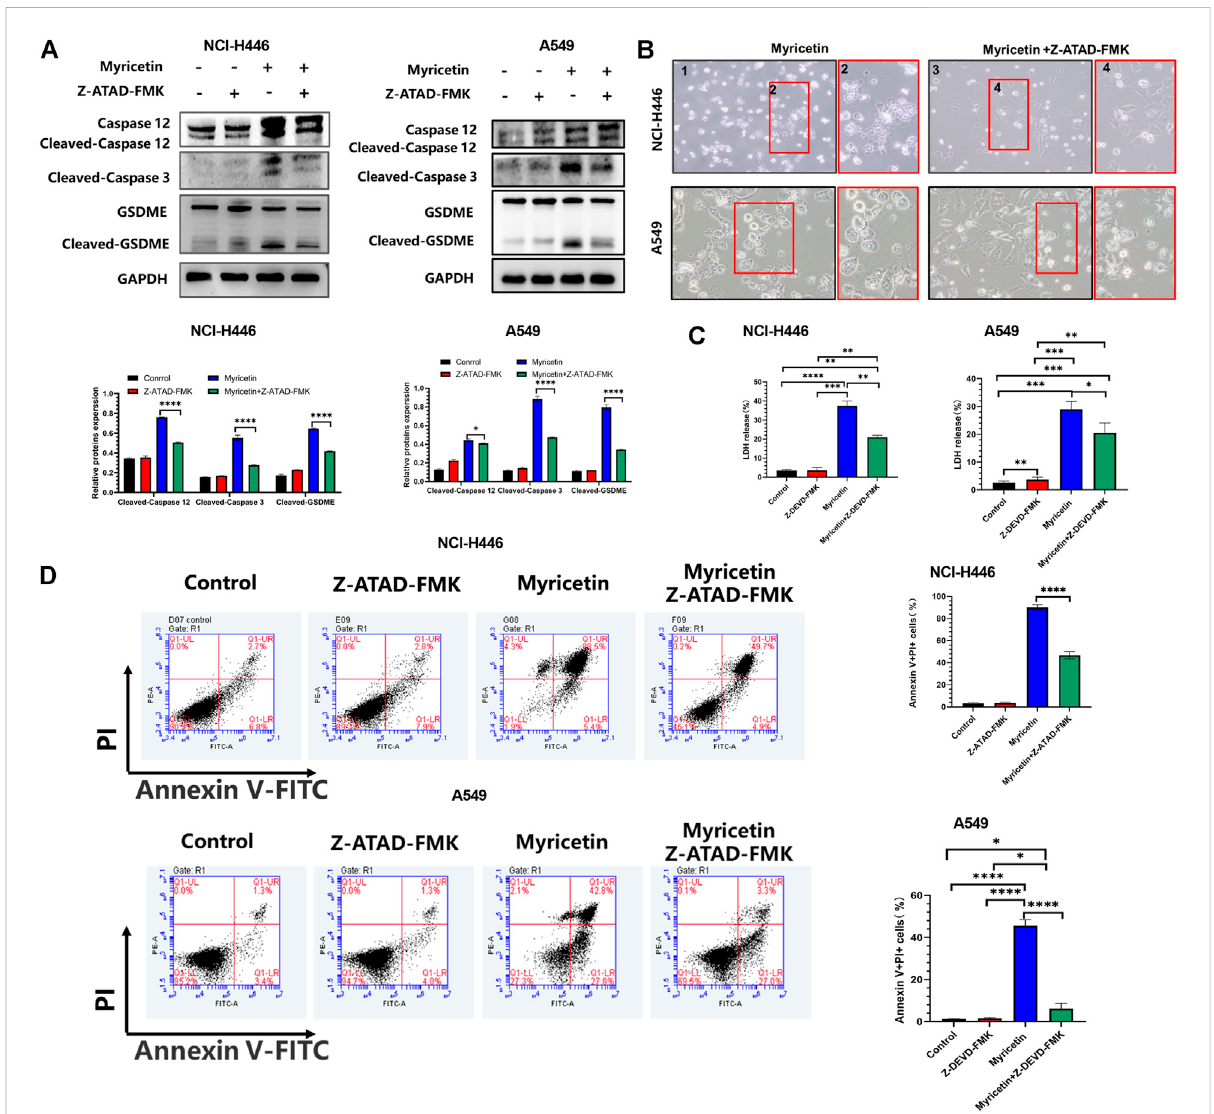
Myricetin induced pyroptosis through the ER Stress pathway. (A) NCI-H446 and A549 cells treated with caspase-12 inhibitor alone, myricetin alone, myricetin and a caspase-12 inhibitor or mock. Expression of cleaved caspase-12, caspase-3, and GSDME and its corresponding statistical analysis. (B) Microscope images of NCI-H446 and A549 cells treated with myricetin and a caspase-12 inhibitor (Z-ATAD-FMK, 50 μ M) or myricetin alone. (C) Detection of LDH release levels. (D) Percentage of NCI-H446 and A549 cells with pyrotosis (stained with AnnexinV+/PI+) and